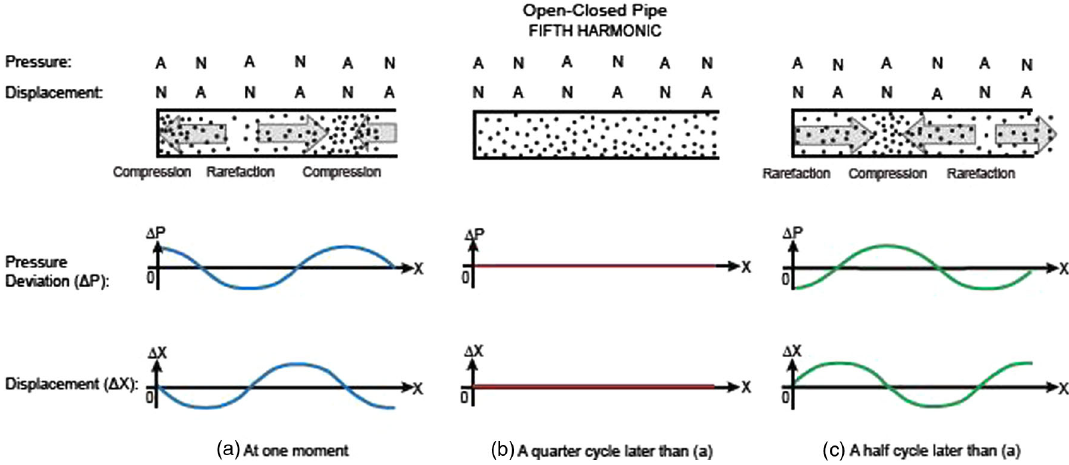
FIG. 14. Fifth harmonic sound standing wave in an open-closed